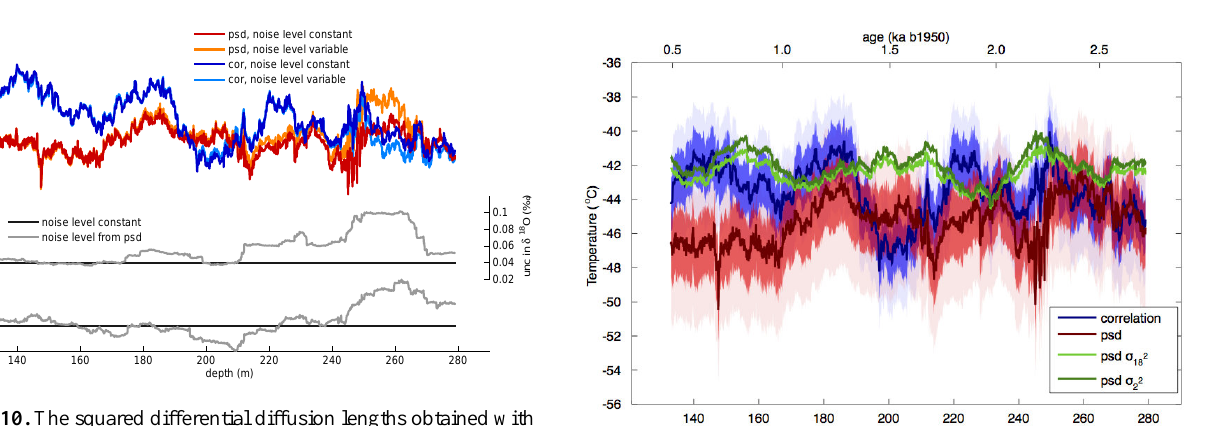
Figure 10. The squared differential diffusion lengths obtained with the PSD and correlation method (a) . For both methods a calculation is done with a fixed noise level and with a noise level determined by the baseline in the PSD spectra ( b and c ).